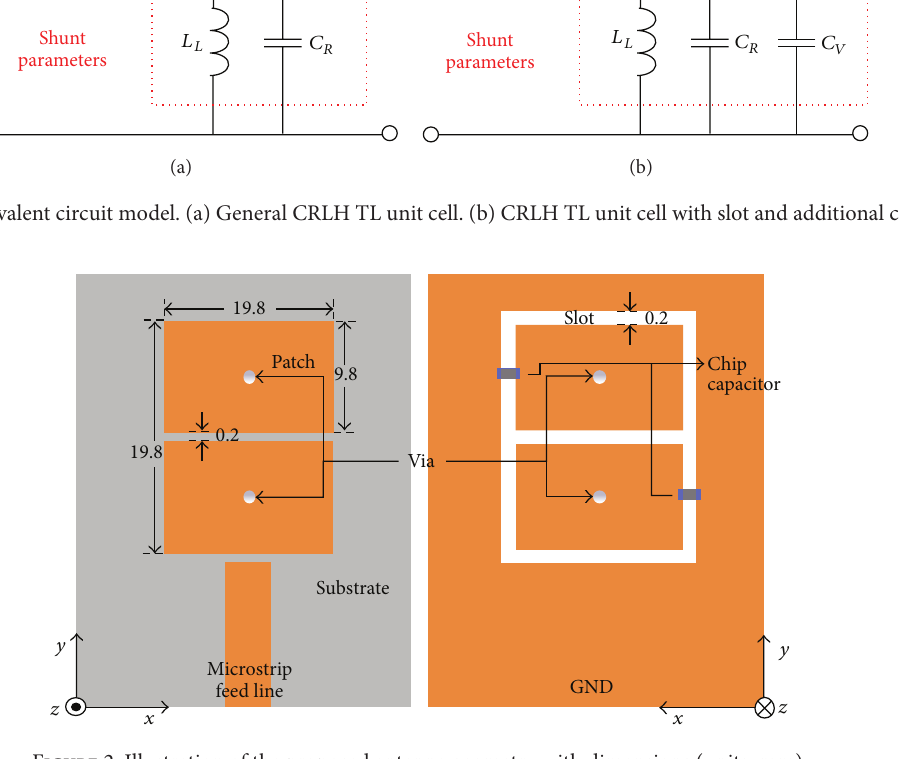
Figure 2: Illustration of the proposed antenna geometry with dimensions (units: mm).